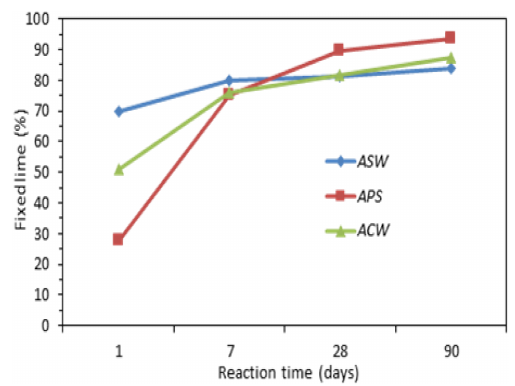
Figure 2. Relative compressive strength (C / S) of blended cements at 2 and 28 days. Table 4. Mineralogical composition by XRD of products from coal mining (SW, ASW and after 28 days of reaction in the ASW–lime